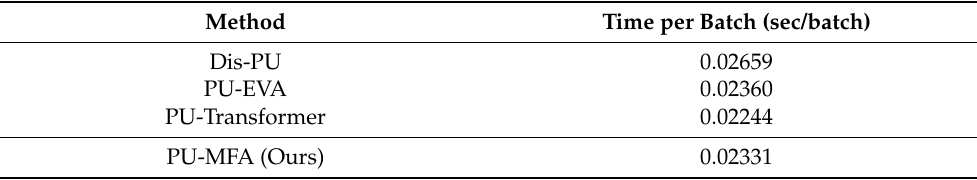
Table 3. Measure average time complexity after 50 measurements on × 4